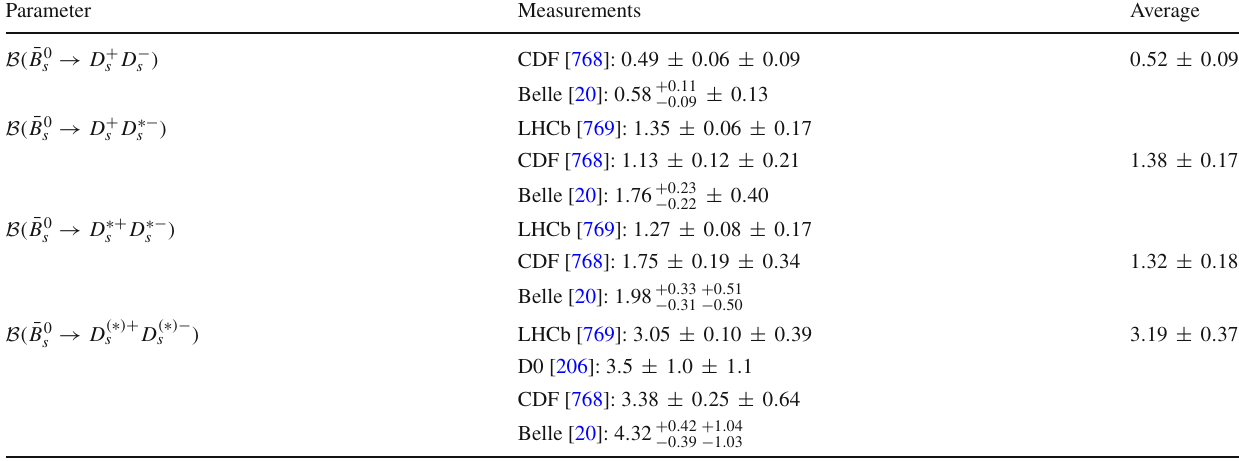
Table 192 Absolute decay rates [ 10 − 2 ]